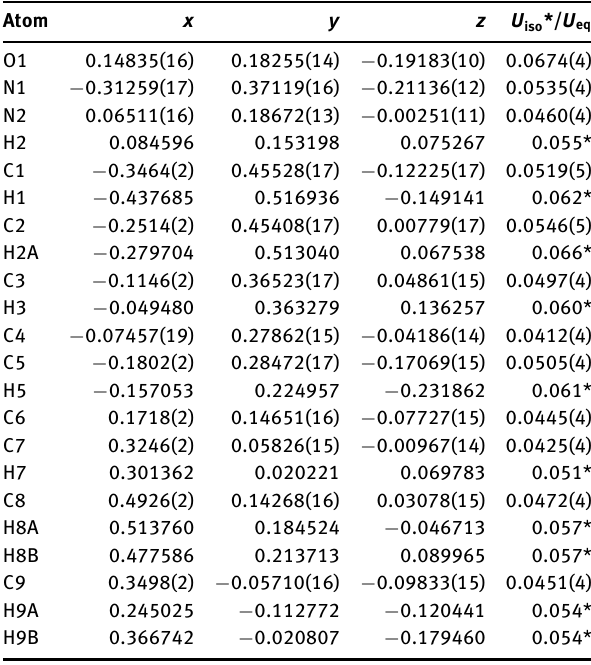
Table 2: Fractional atomic coordinates and isotropic or equivalent isotropic displacement parameters (Å 2